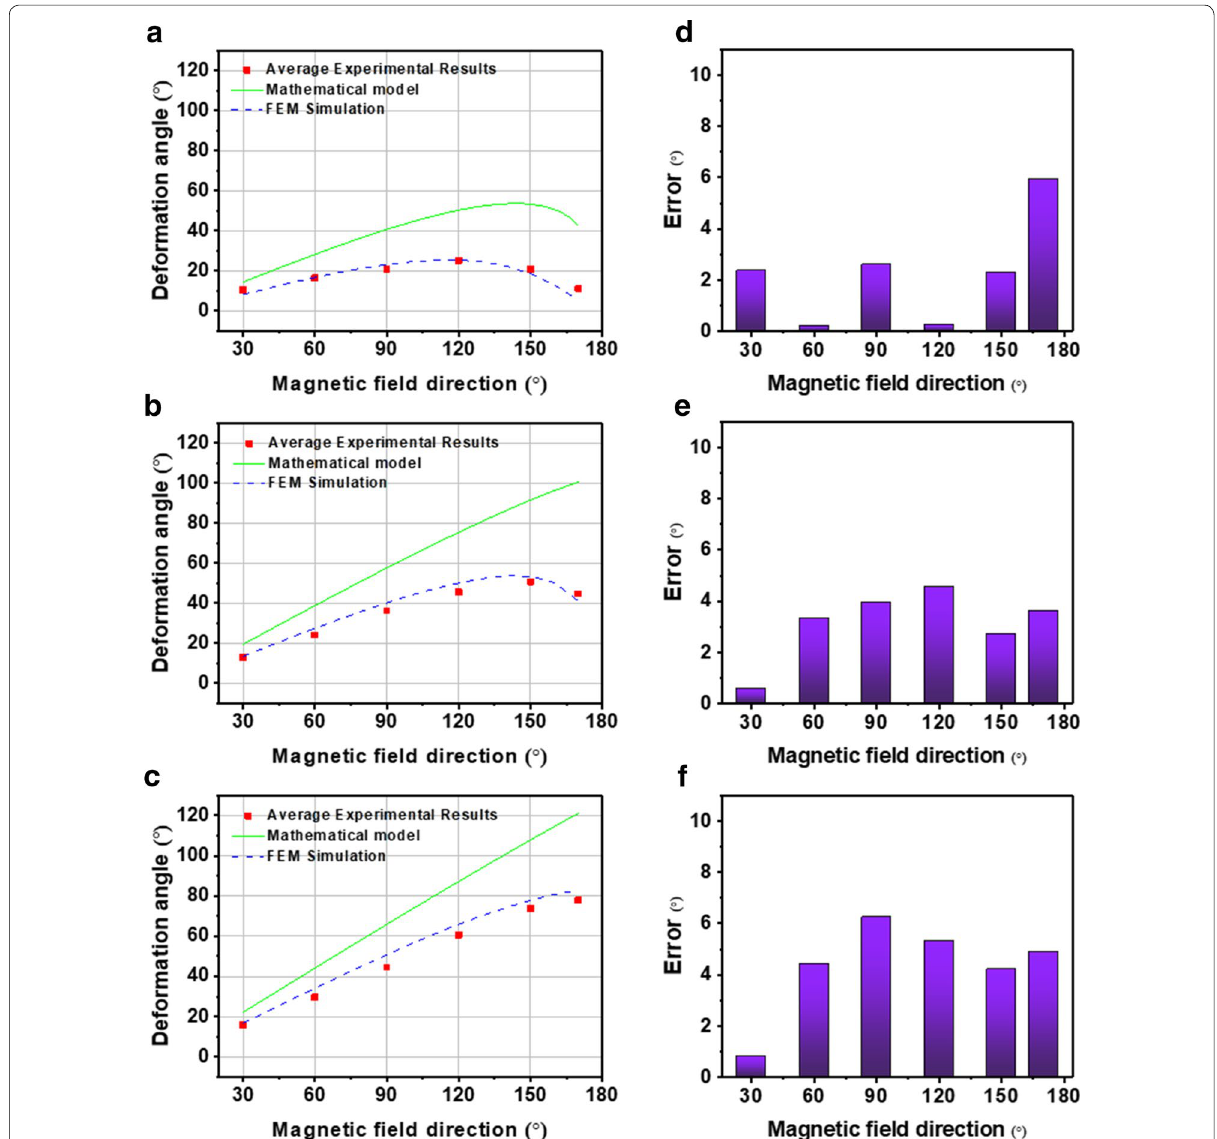
Fig. 6 Comparison between the results of the mathematical model, the finite element model (FEM), and experiments when the deformation angle of the flexible microrobot was affected by the magnetic field direction (which varied from 0 to 170°) at magnetic field intensities of a and d 5 mT, b and e 10 mT, c and f 15 mT. d , e and f show errors between simulated and experimental